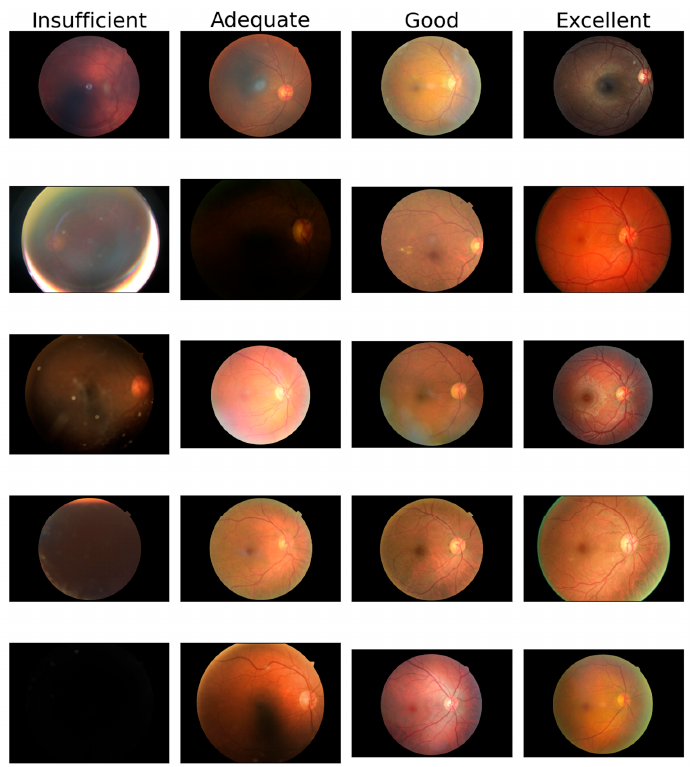
Figure A1. Detailed architecture of the ensembles.